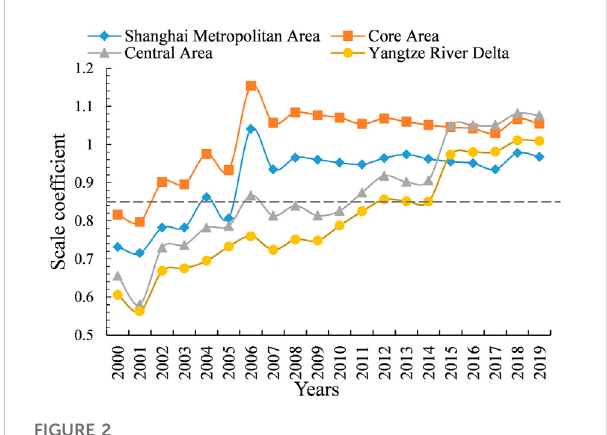
FIGURE 2 Change in the scale coef fi cient of population-land allometric growth in the YRD